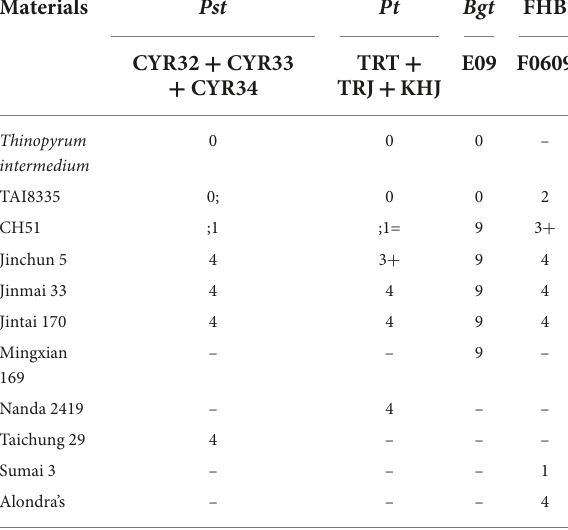
TABLE 2 Responses of tested materials to stripe rust ( Pst ), leaf rust ( Pt ), powdery mildew ( Bgt ), and FHB at the heading